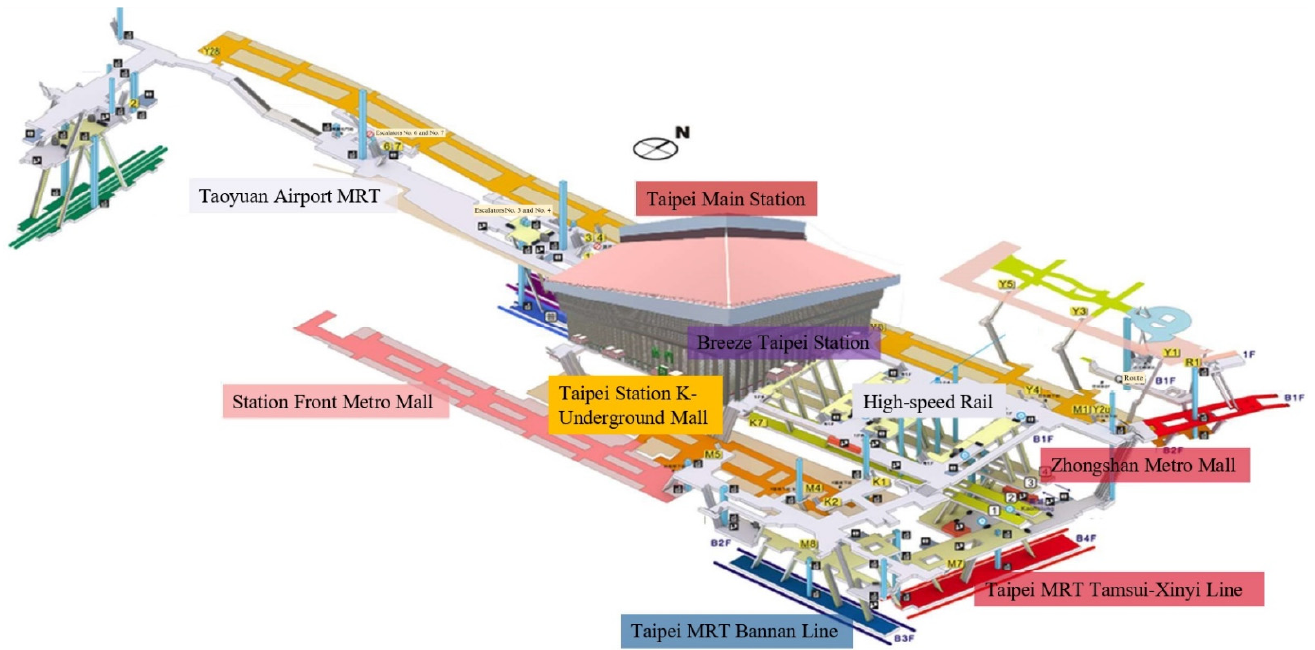
Figure 1. Areas of Taipei main station. (Source: Taipei Main Station Intelligent Joint Disaster Prevention Center, 2020).